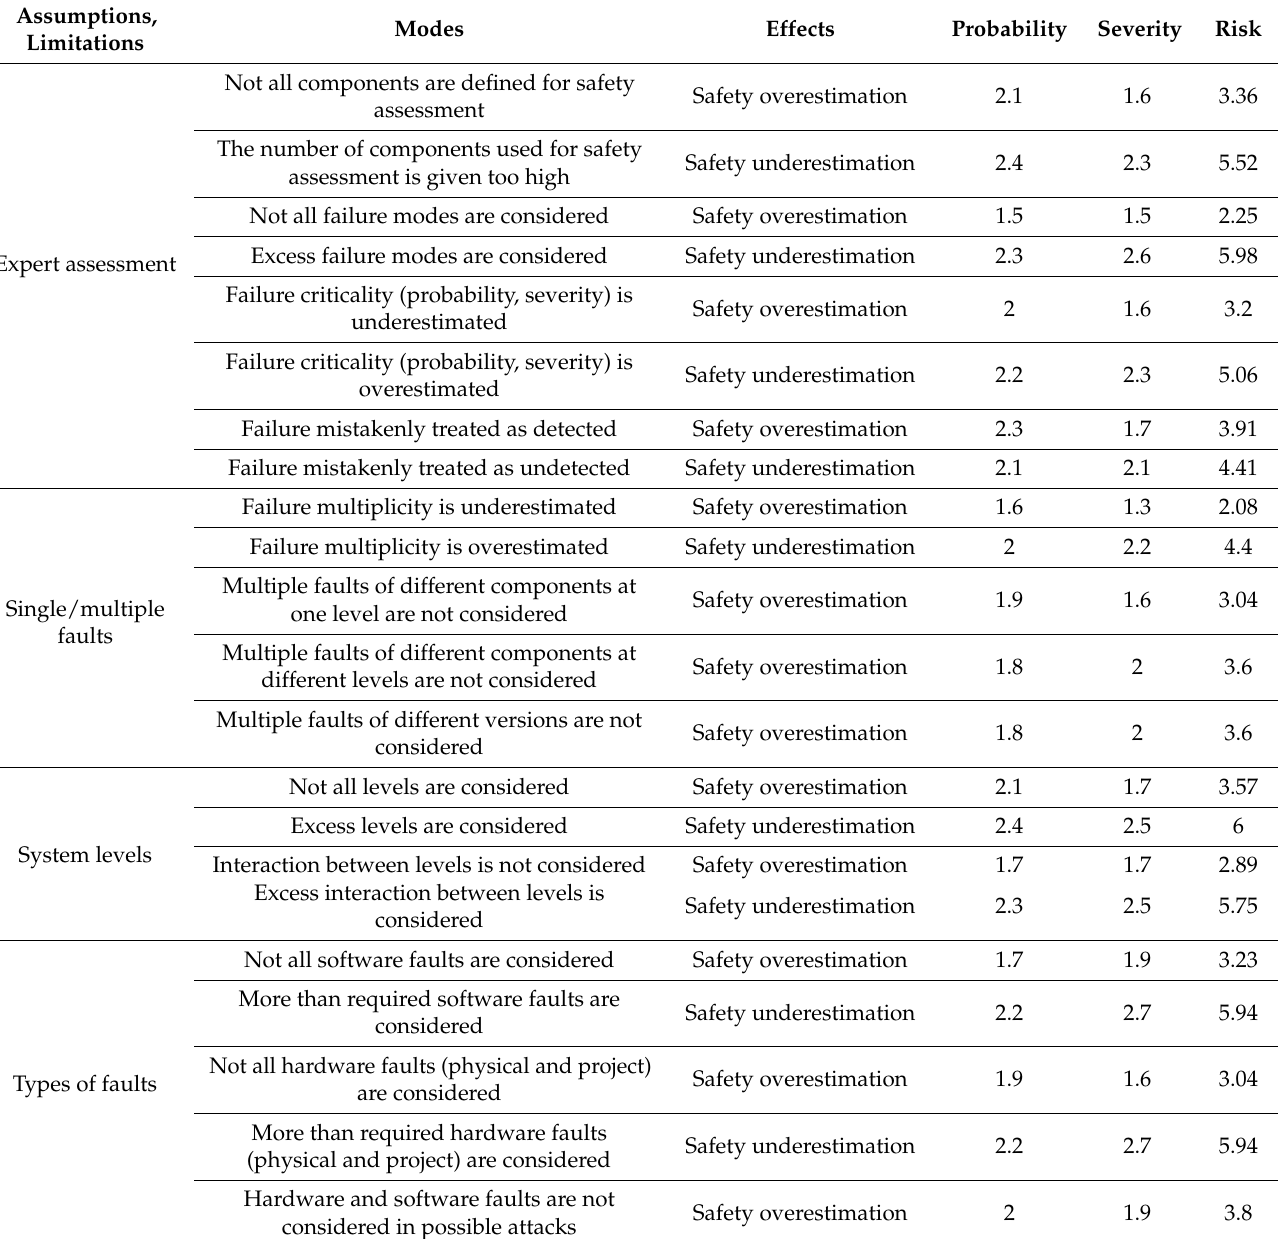
Table 4. EUMECA results.